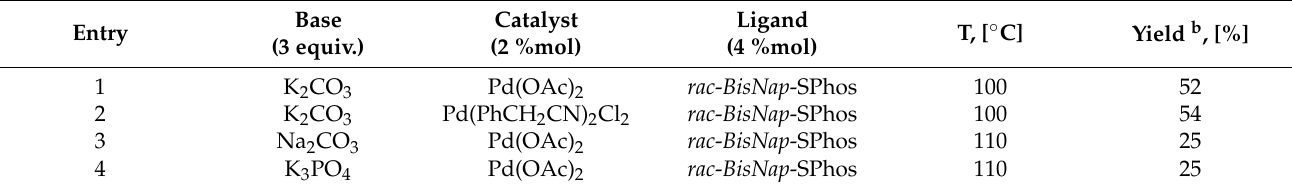
Table 6. Synthesis of 15 in protic solvent under microwave conditions a